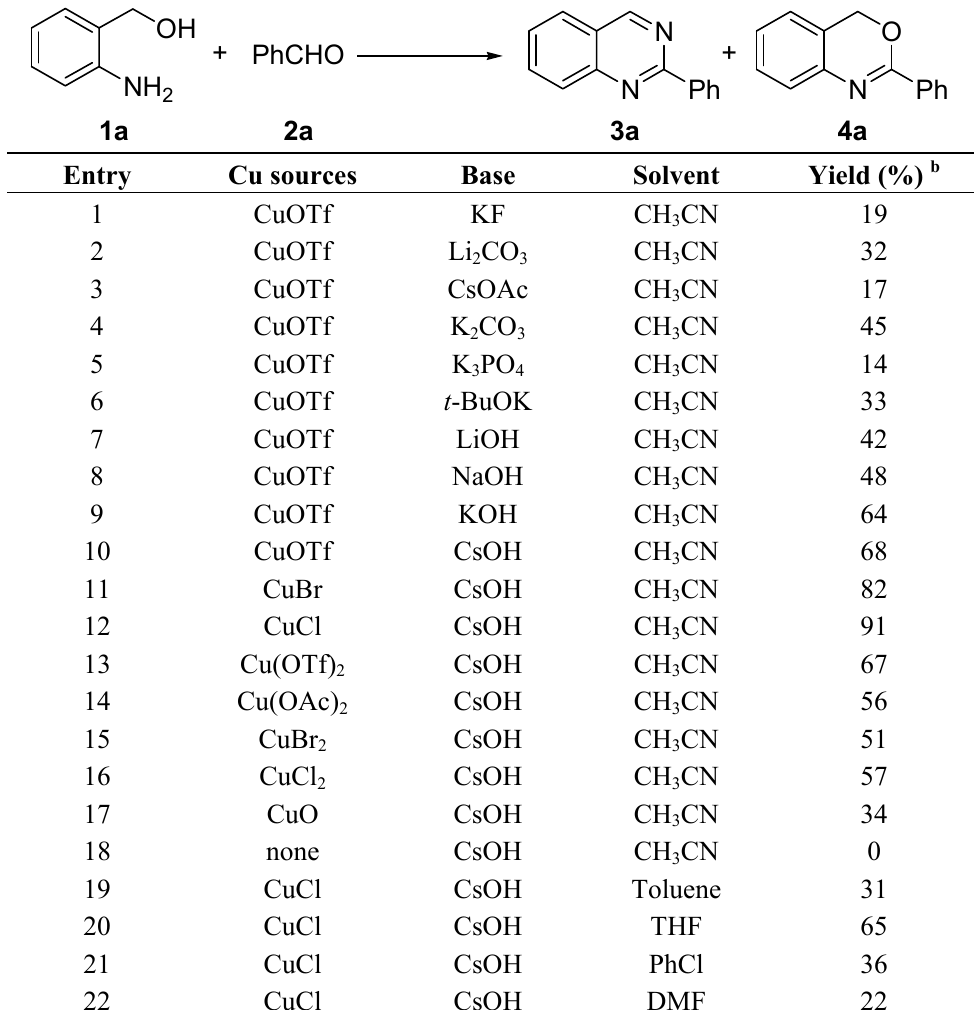
Table 1. Optimization of the reaction conditions a